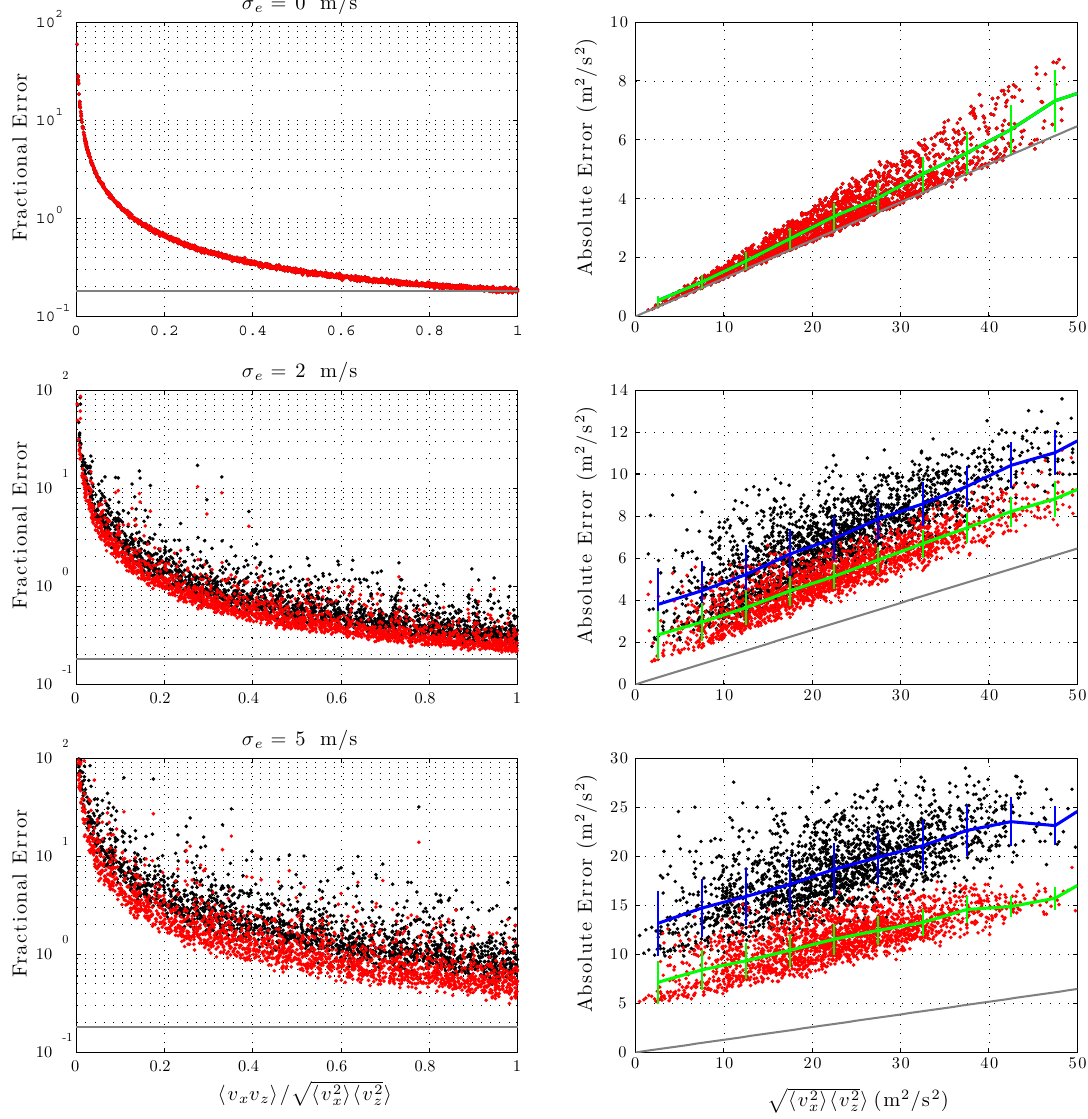
Fig. 5. The top row corresponds to σ e = 0ms − 1 , the middle row to σ e = 2ms − 1 , and the bottom row to σ e = 5ms − 1 . Left: Fractional error in horizontal momentum flux determination as a function of horizontal to vertical wind correlation. As the correlation approaches 1, √ √ N 3 = 0 . 18 (solid horizontal line). Right: Absolute error in horizontal momentum flux as a function of the fractional error approaches 2 / q h v 2 x ih v 2 z i (where results for h v e v z i and h v n v z i have been merged). Blue and green lines with errorbars show mean and 1 σ spread for the q h v 2 x ih v 2 z i /N black and red points, respectively, and gray line corresponds to 3 . In all panels, black dots are from the simulation neglecting the covariance terms, where red dots are from the approach described in the